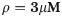
Time evolution of the uncertainty on the estimations, ρ=3μM.A priori
kon0=0.031min-1μM-1, kdep0=0.09min-1, kdis0=0.07min-1, θ0 = 0.2, observation covariance W = 8, predicted standard deviation of initial a priori estimations as in Table 2. A: 19 iterations of the Extended Kalman method, number of the iteration in colorscale. B: Trajectories of the final estimators (red lines), the final estimations (red dashed lines) and 95% prediction uncertainty intervals (red areas). From the left to the right estimators of kon, kdep, kdis and θ.